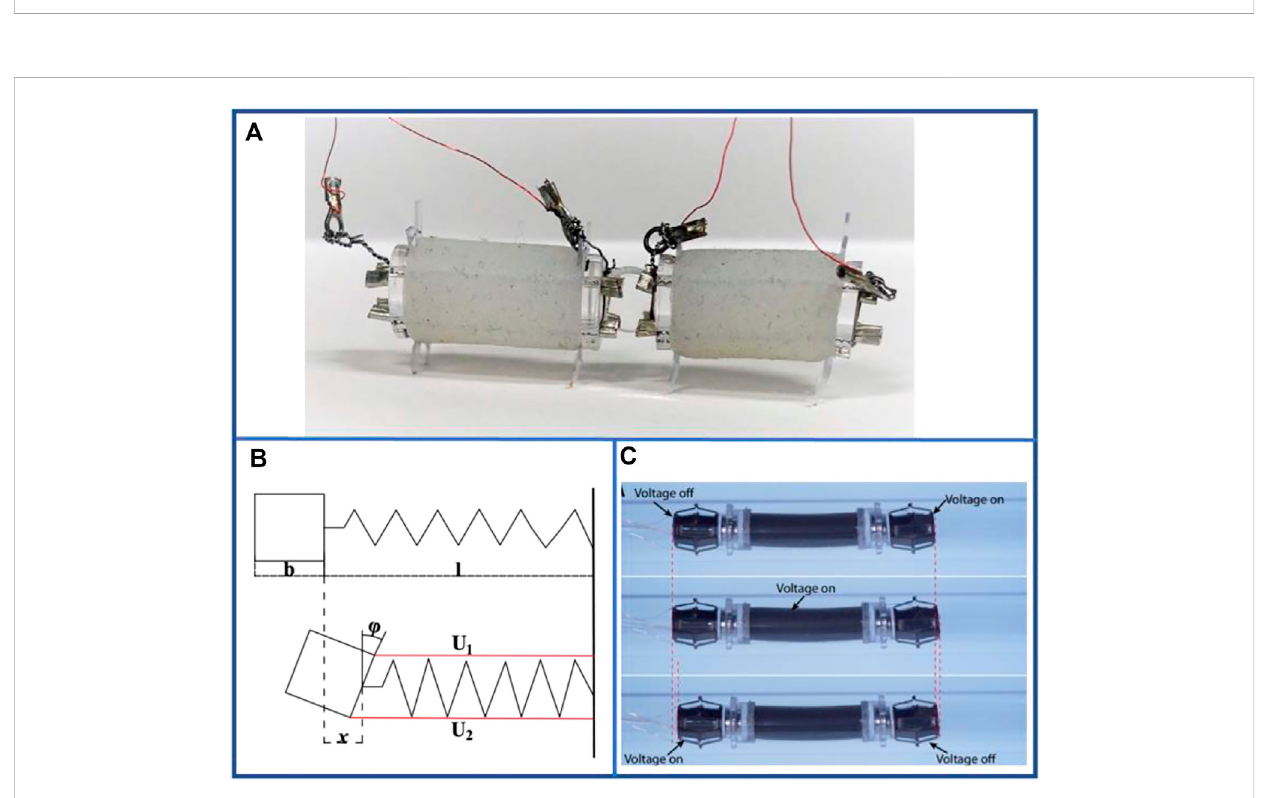
FIGURE 14 Examples of electro-deformable material-drivenmulti-segment earthworm-inspired softrobots. (A) Earthworm-like two-segment hydrostatic soft robotdrivenbySMA(Chatterjeeetal.,2017).ReproducedfromRef.(Chatterjeeetal.,2017).withpermission. (B) Themethodoftherotarymotionofrobot with different applied voltages. (C) Structure and movement of sub-centimeter robot based on DE (Tang et al., 2022). Reproduced from Ref. (Tang et al., 2022). with